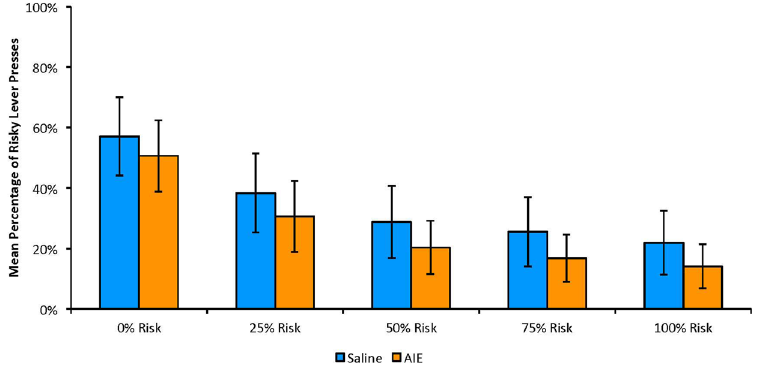
Figure 3. Mean ( ± SEM) percentage of risky lever presses in choice trials at each risk level, averaged across the 5 days post-stability for each animal. No significant treatment effect found (p’s >